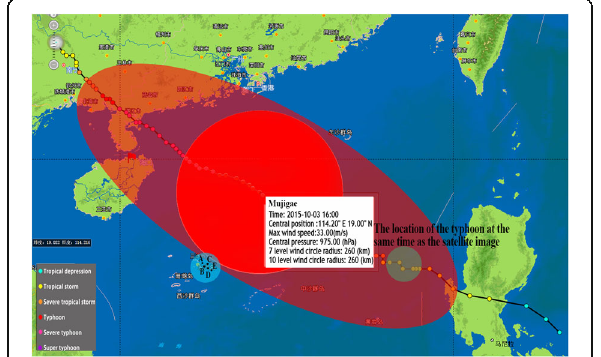
Fig. 5 The curve of spectrum of seawater before the atmospheric correction